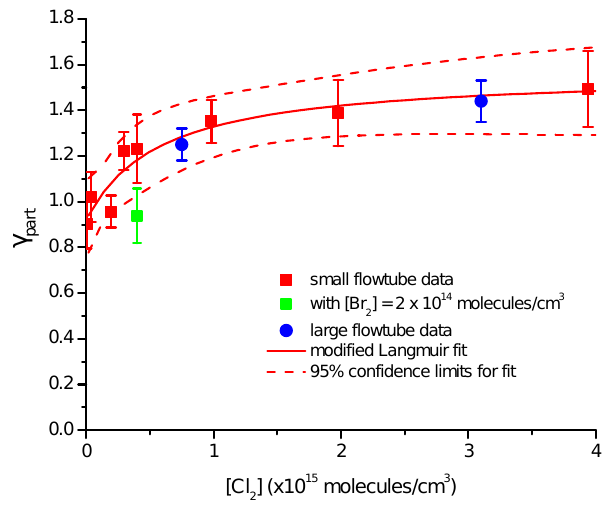
Fig. 6. Effective reactive uptake coefficient, γ part , for Cl on 2- ODA particles as a function of Cl 2 concentration. The Langmuir- type adsorption isotherm used to fit the data, Eq. (4), is also shown with 95% confidence intervals. The best fit parameters are: γ o = 0 . 92 ( ± 0.07), K = 1 . 72 ( ± 1.23) × 10 − 15 cm 3 molecule − 1 , and f = − 1 . 42 ( ± 0.30). Br 2 adsorption decreases the observed rate of reac-